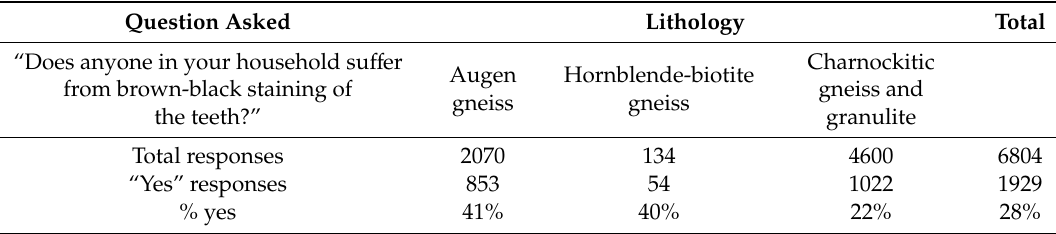
Table 2. Summary statistics of dental fluorosis indicator data and corresponding